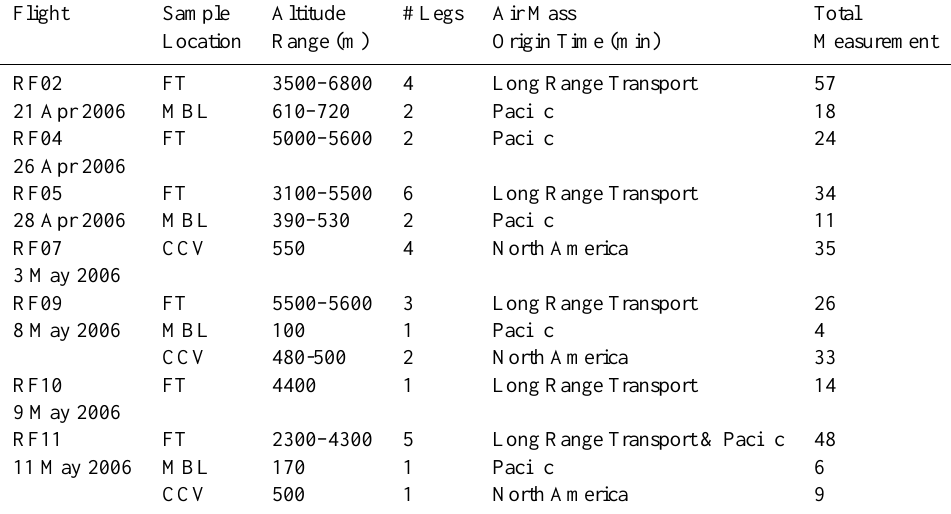
Table 1. Summary of altitude ranges, air mass locations and origins for flight legs analyzed.